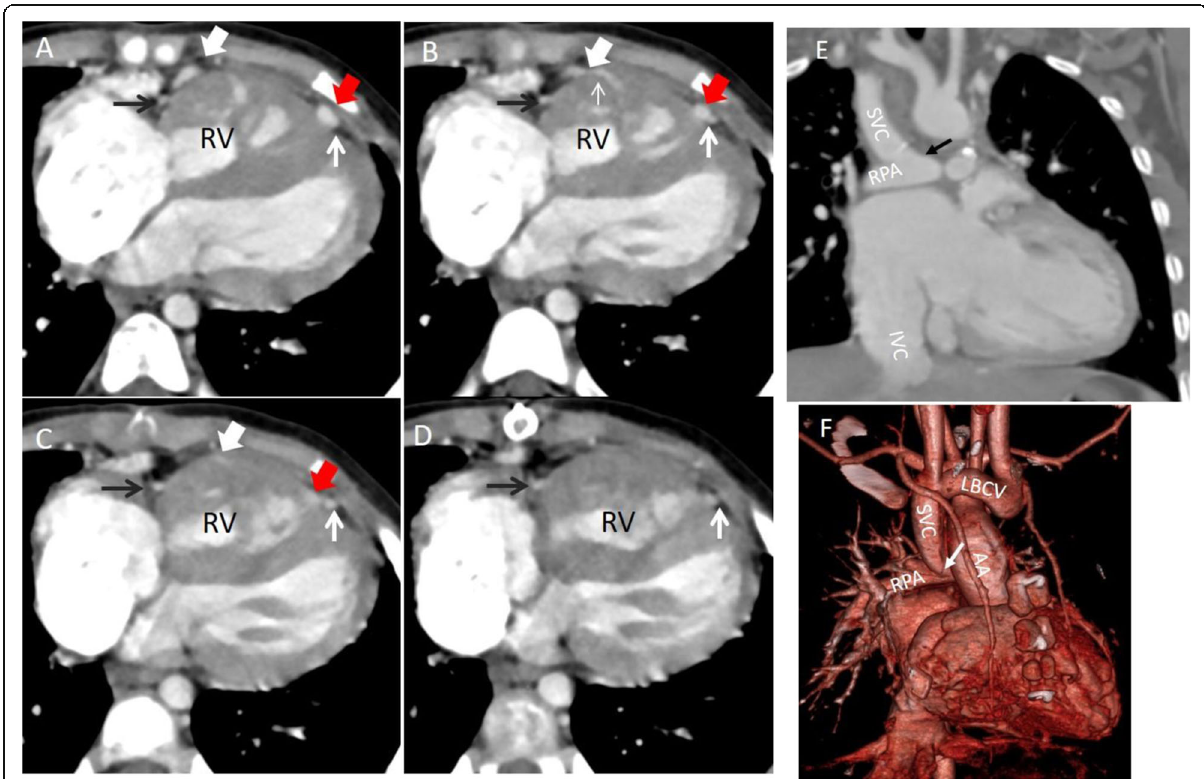
Fig. 9 3-year-old-girl with pulmonary and tricuspid atresia, post-Glenn surgery, on aspirin. She developed hemoptysis therefore CTA was requested. a – d Sequential axial CTA images show marked RV hypertrophy with fistula (block white arrow) between RV cavity and right coronary artery (RCA = black arrow). Another fistula (red and black arrows) between RV cavity and the left anterior descending artery (LAD = white arrow). The RV-RCA fistula shows focal stenosis (thin white arrow in b ) whereas the RV-LAD fistula shows focal aneurysmal dilatation. e 2D coronal MIP reformat and f 3DVR shows patent SVC-RPA anastomosis (arrow) without